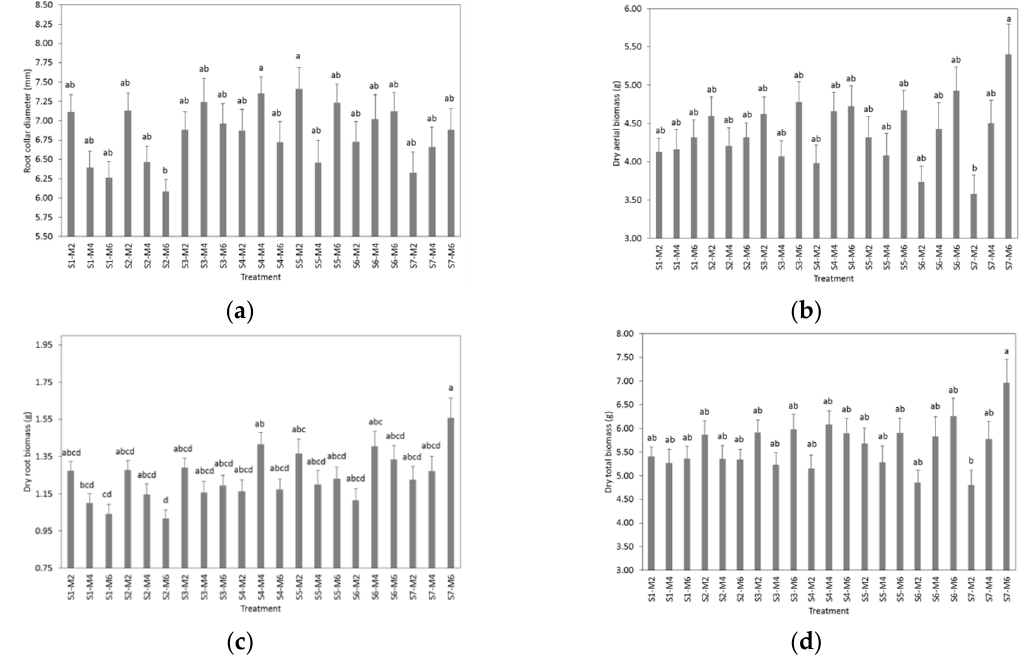
Figure 2. Variables evaluated in Pinus engelmannii : Root collar diameter ( a ), dry aerial biomass ( b ), dry root biomass ( c ) and dry total biomass ( d ). Differences between letters indicate significant differences between treatments (Bonferroni, α = 0.05).